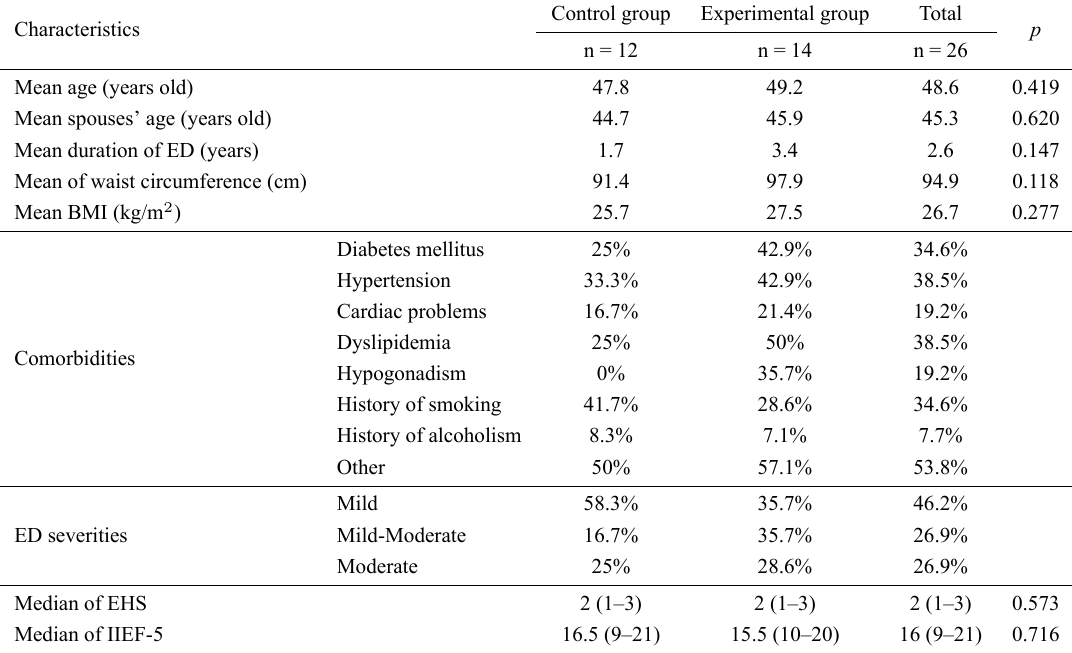
Table 1. Subjects